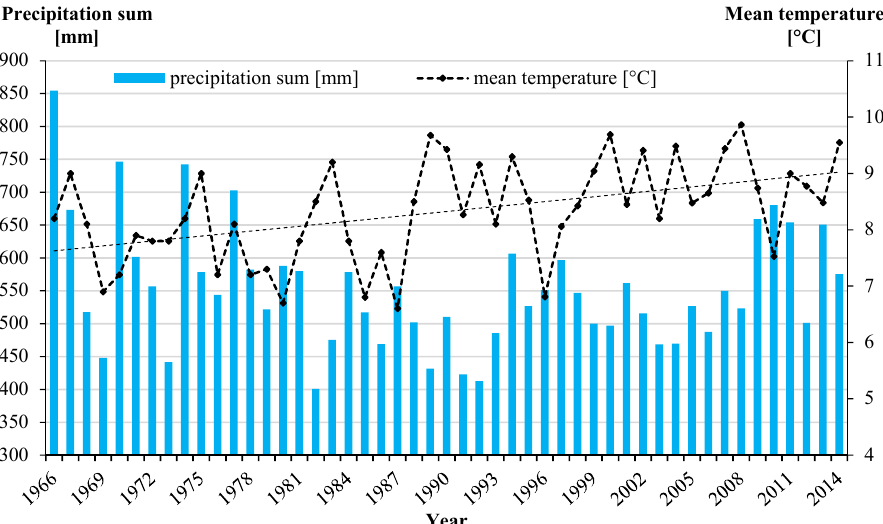
Figure 1. Annual precipitation sum [mm] and mean air temperature [°C] in 1966–2015 period in Warsaw University of Live Science Experimental Station in Skierniewice, Poland. A significant increasing linear trend (black dotted line) is shown for annual air temperature (β = 0.03, R 2 = 0.22, p -value = 0.0006) Monthly values (mean, min and max) for precipitation and air temperature are shown in Table A2 (Appendix).